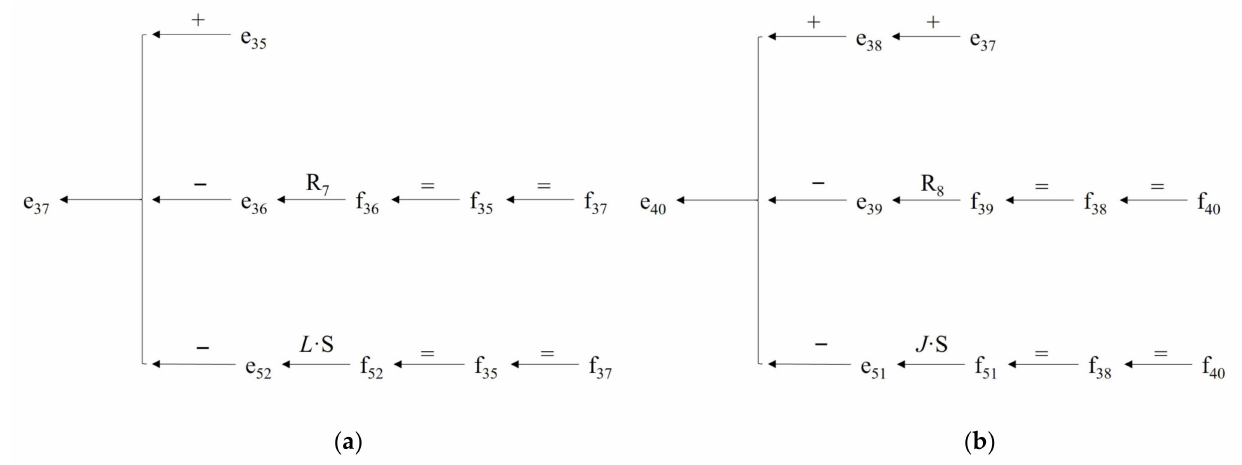
Figure 18. TCG of the reactor coolant pump: ( a ) for the motor module; ( b ) for the mechanical module; ( c ) for the hydraulic module TCG.